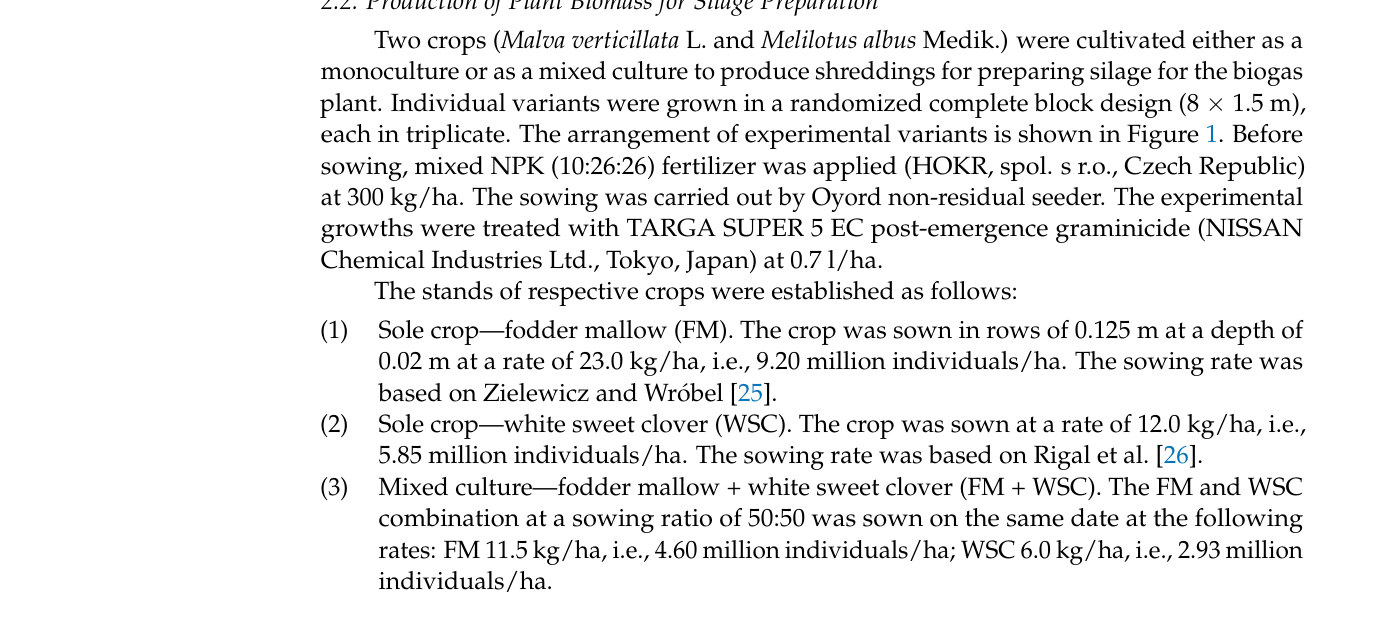
Legend to Table 1: Mean of measured values ( n = 3) is shown ± standard deviation